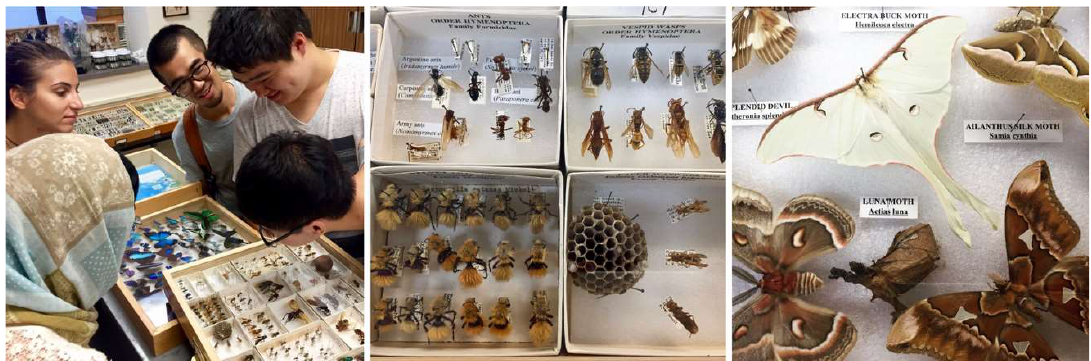
Figure 1. Students on a field trip to UC Berkeley’s Essig Museum of Entomology.